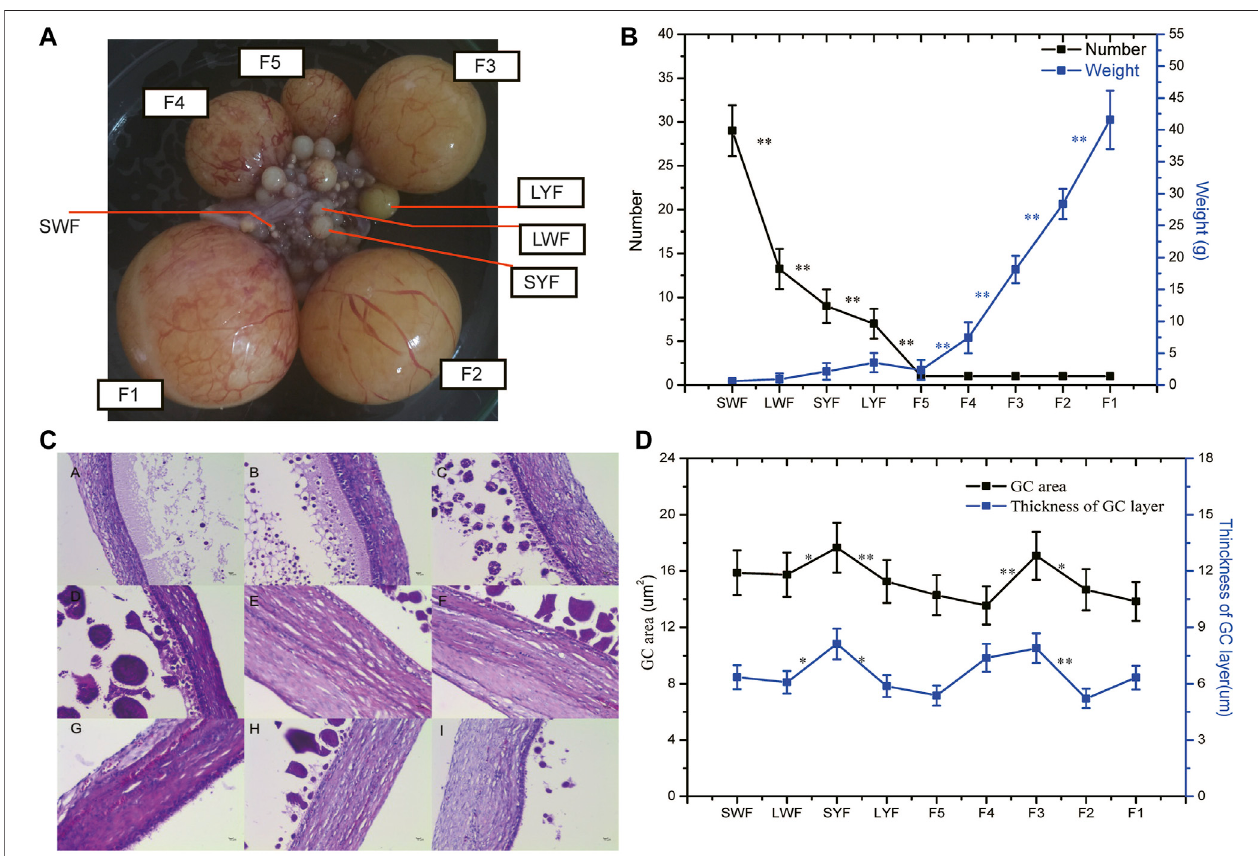
FIGURE1| TheweightsandphenotypicdifferencesinthevarioussizesoftheGCs.Note (A) ,Thephenotypicofgoose follicles; (B) ,Thenumbersandweightofthe goose follicles; (C) , Histological staining for follicular tissues using hematoxylin-eosin (HE); (D) , The granular cell area and thickness of the granulosa layer cells.